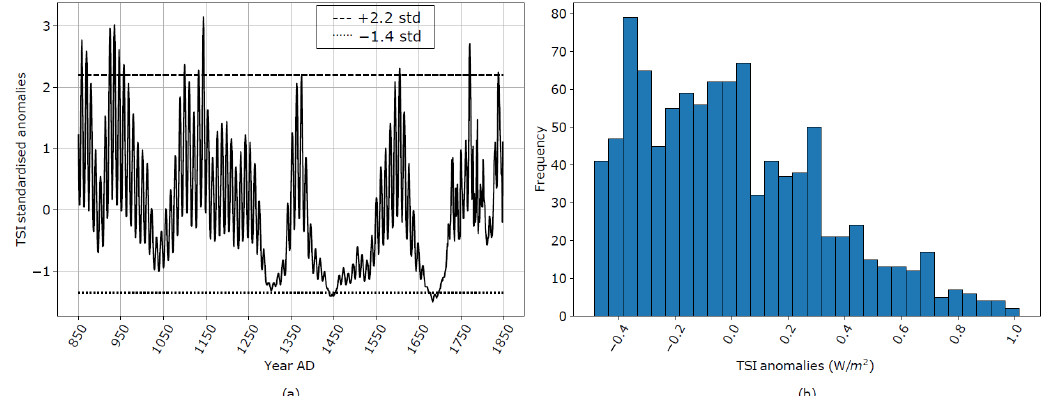
Figure 1. ( a ) Standardized TSI anomalies for the period 850–1849 AD, and ( b ) TSI anomalies for the period 850–1849 AD as a function of frequency. The data regard the Vieira et al. [18] TSI reconstruction over the Holocene.